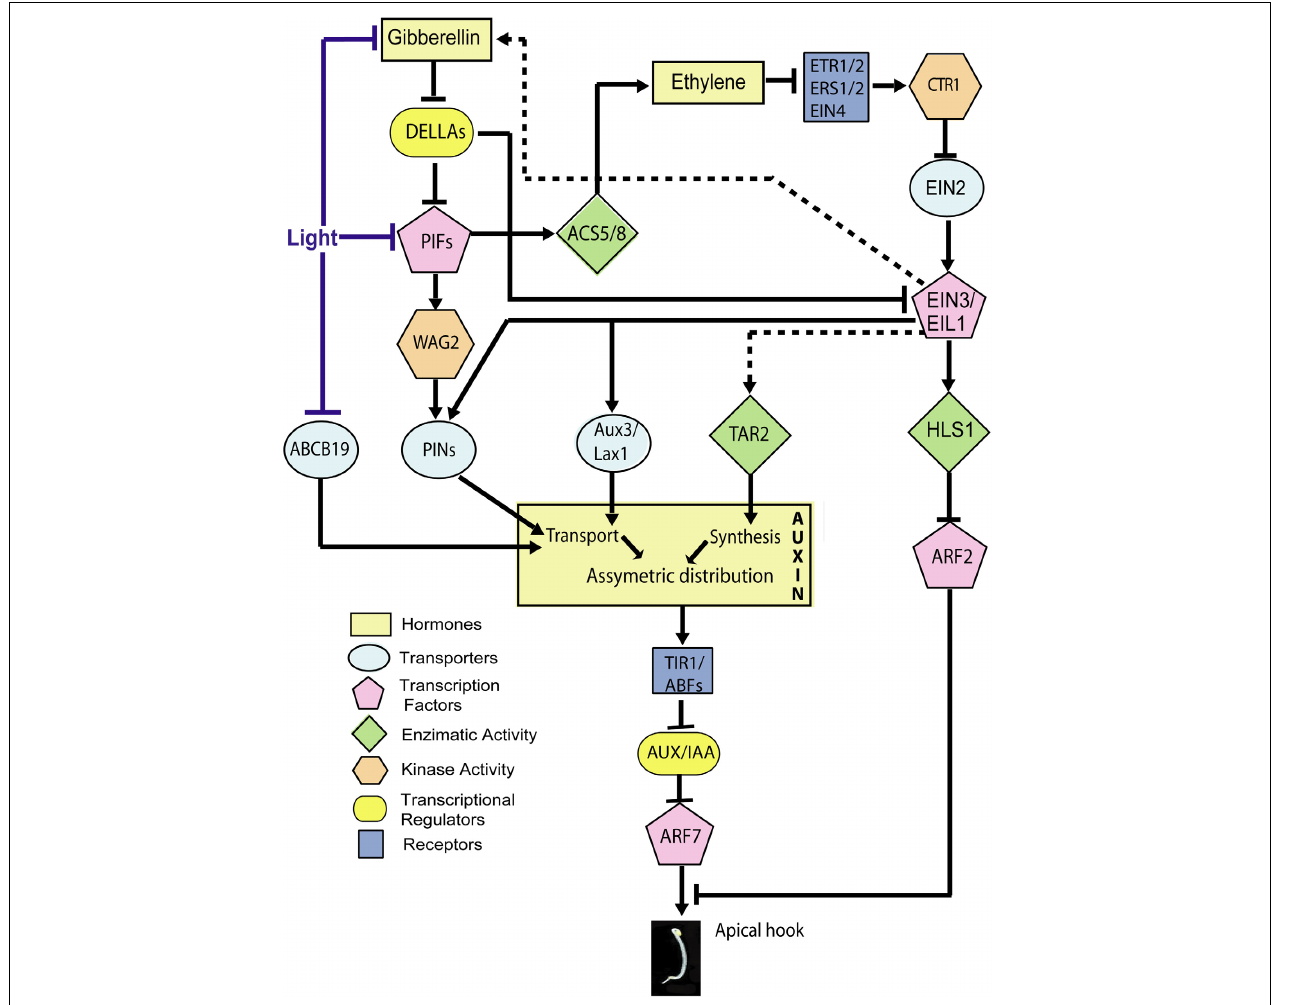
FIGURE 3 | Hormone signaling network involved in the inhibition of growth at the inner side of the apical hook by auxin. Established points of action of light during hook opening are indicated. The scheme includes only the components for which specific experimental evidence for a role in apical hook development is available (therefore, for instance, while GID1 should work between Gibberellins and